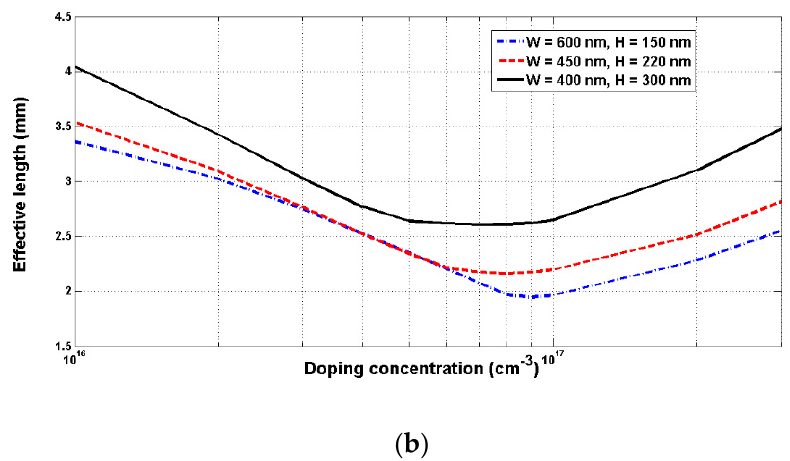
Figure 3. ( a ) Minimum phase shifter loss versus the doping concentration. ( b ) Corresponding effective length versus the doping concentration.